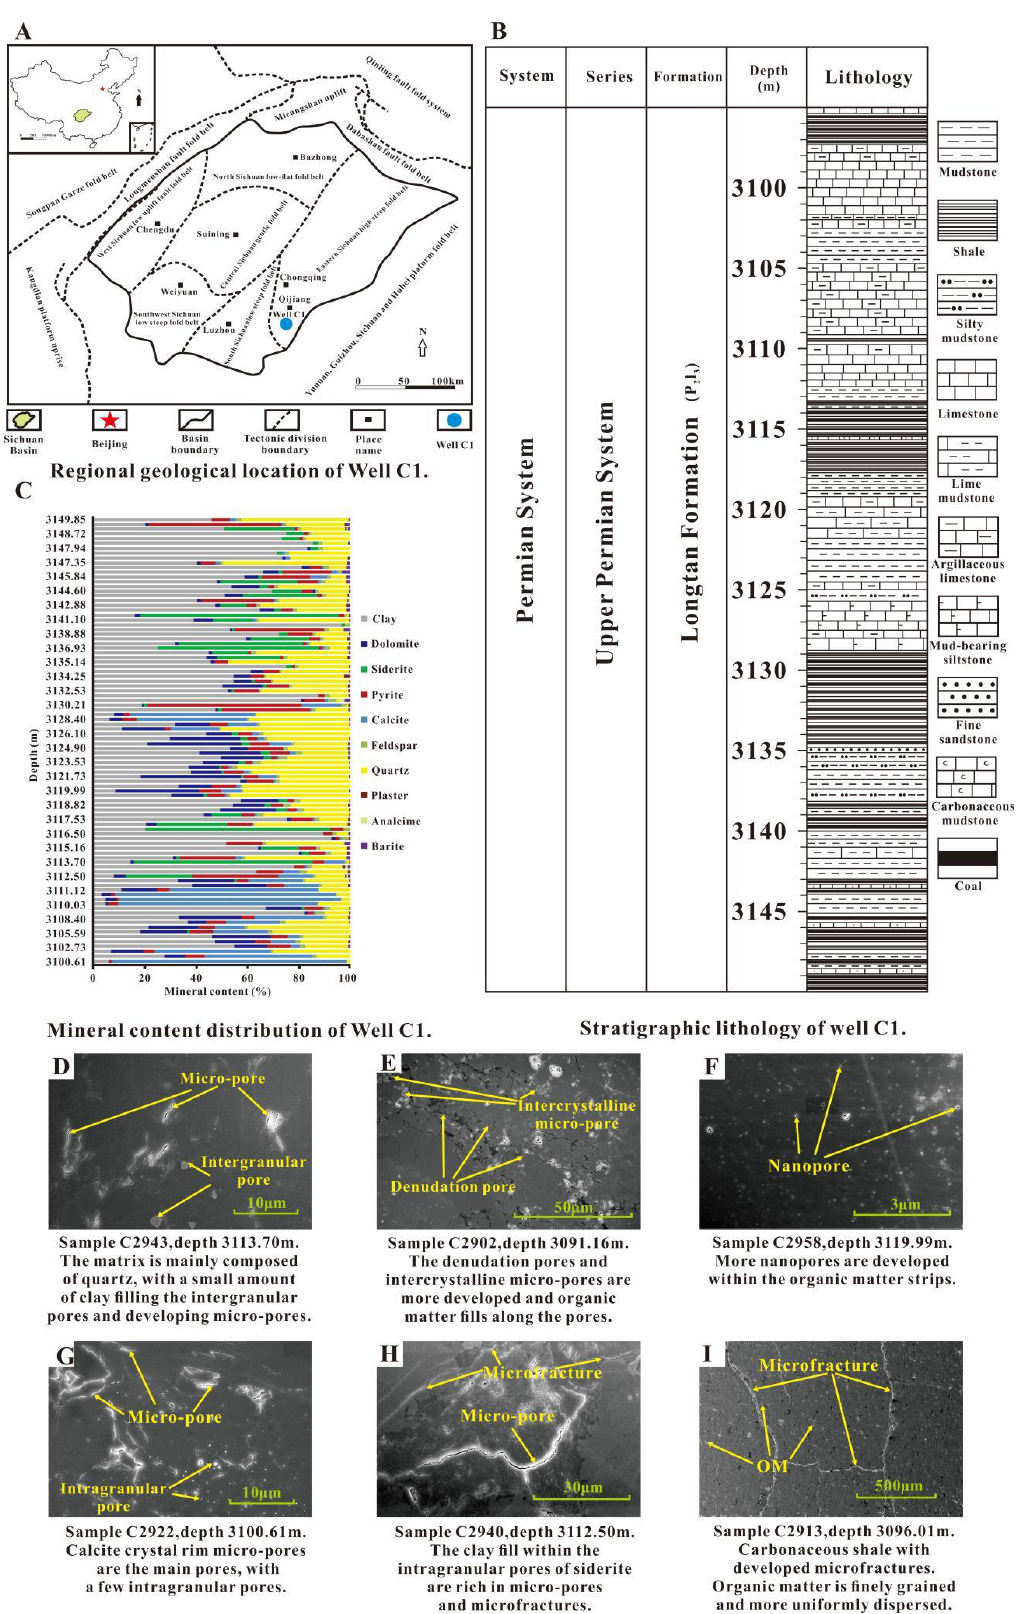
Figure 3. Location ( A ), lithology ( B ), mineral X-ray diffraction ( C ) and argon ion scanning electron microscope ( D – I ) parameters of well